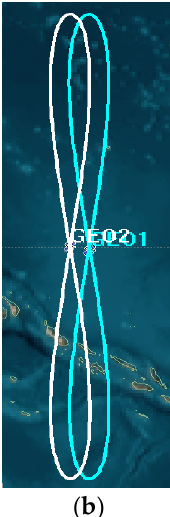
Figure 1. GEO InSAR formation. ( a ) Sketch map; ( b ) Nadir tracks.